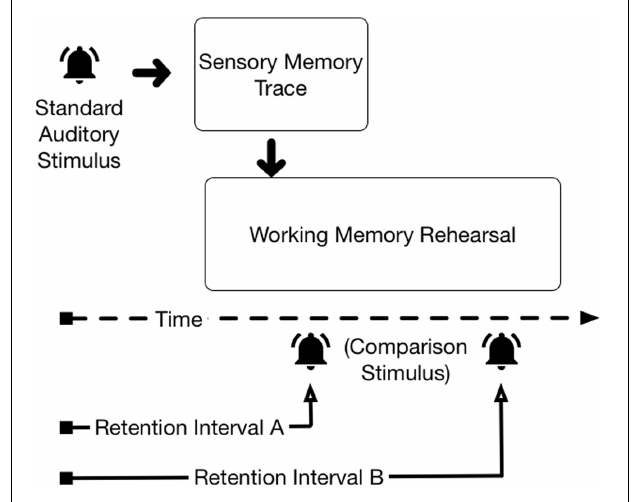
FIGURE 1 | Hypothetical availability of the ASM trace for two different retention